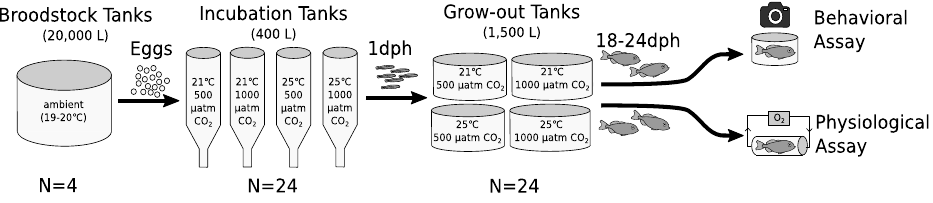
Figure 1. A schematic diagram of the broodstock, egg, and larval maintenance of yellowtail kingfish prior to behavioral and physiological testing. Illustration by Erin Walsh.